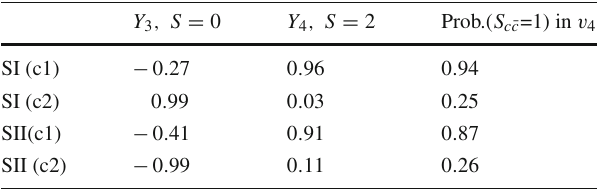
Table 5 First two columns: components of the eigenvector v 4 belong- ing to the highest eigenvalue, M 4 , in the basis Y 3 , Y 4 . Third